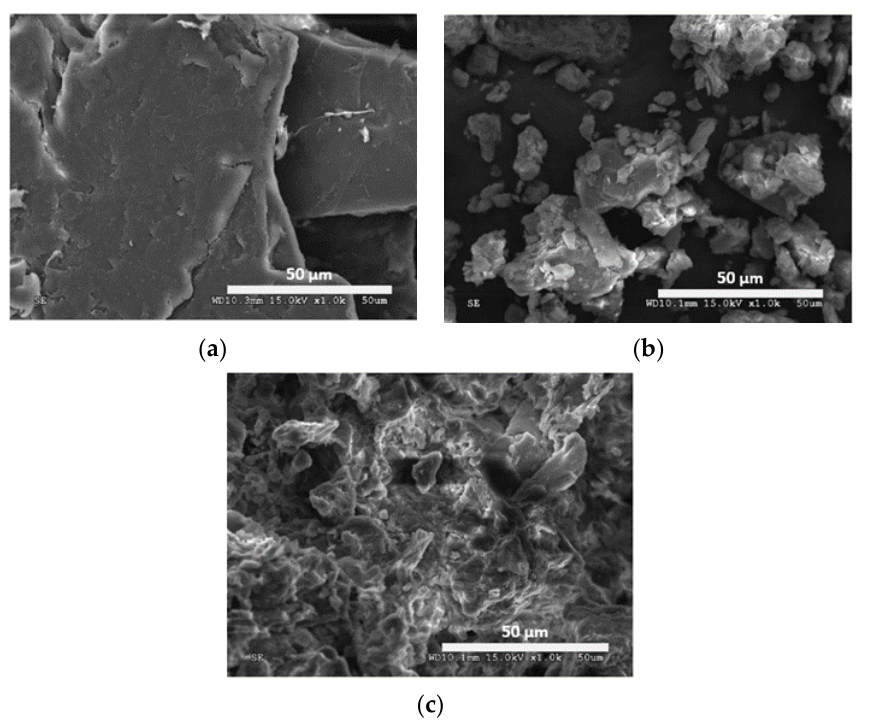
Figure 1. SEM micrographs of ( a ) chitosan, ( b ) bentonite, and ( c ) CCB.